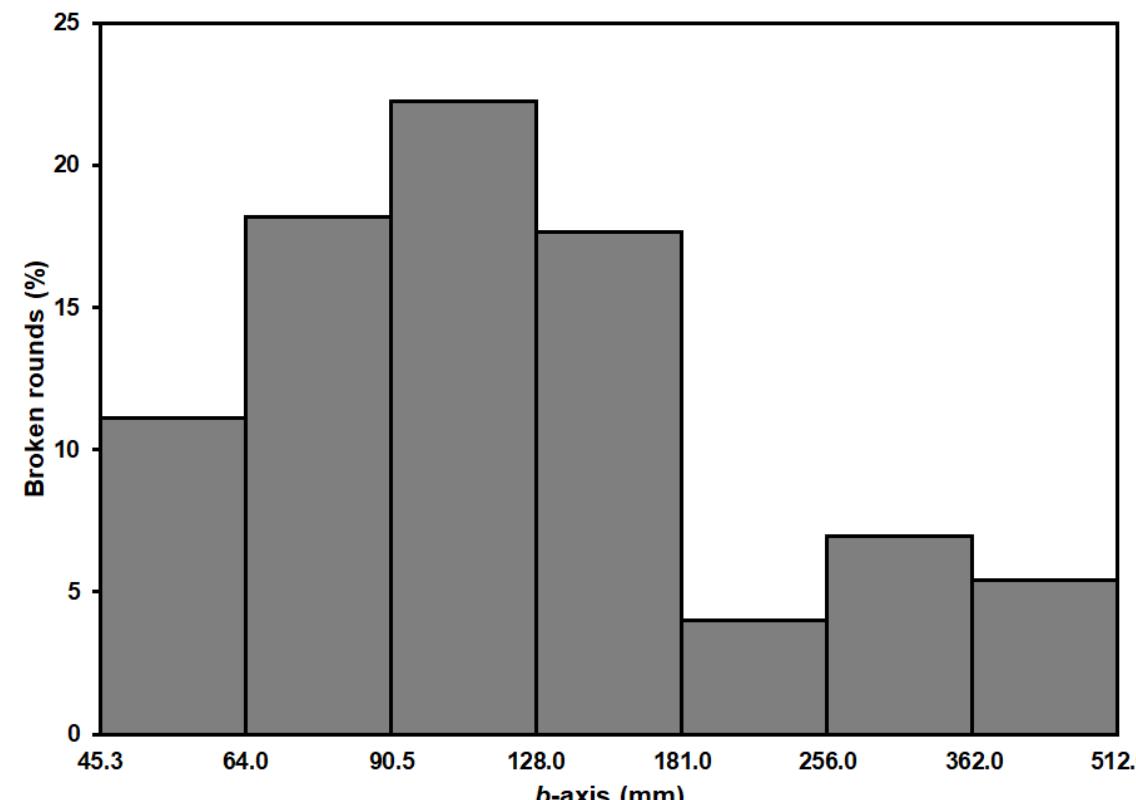
Figure 8. The incidence of broken rounds as a function of particle size in beach gravels on Lennox Head Beach, northern New South Wales, Australia. Note that the broken rounds are the products of splitting; the process itself is thus likely to be of greatest importance in the >181.0 mm fractions.